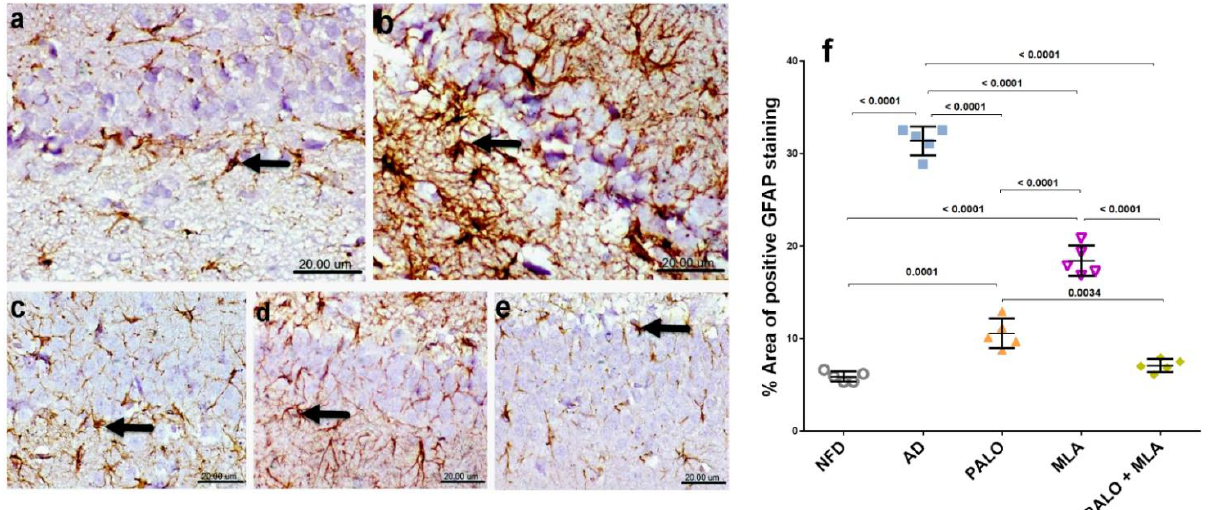
Figure 10. Effects of PALO and/or MLA on hippocampal CA1 immuno-histopathological examination of astrocytes in HFFD/LPS-induced AD model. Immunohistochemical analysis of GFAP expression in the CA1 region of hippocampus of rats in ( a ) NFD group shows normal small-sized astrocytes with lightly stained GFAP positive short processes (arrow), while sections of ( b ) AD model show strong immunoreactivity of hypertrophied astrocytes with deeply stained GFAP positive brown processes (arrow). On the other hand, section of ( c ) PALO treated group shows mild GFAP positive expression (arrow) and section of ( d ) MLA treated group shows moderate GFAP expression (arrow). Meanwhile, section of ( e ) PLAO + MLA treated group depicts normal small-sized astrocytes with lightly stained GFAP (arrow) processes (Scale bar 20 µ m, × 600). Panel ( f ) represents the % area of positive GFAP staining from 5 randomly chosen fields in each section. Data were analyzed using one-way ANOVA followed by Tukey’s post hoc test; p < 0.05 PALO (0.1 mg · kg − 1 ; i.p) and/or MLA (5.6 mg · kg − 1 ; i.p) were administered 3 h after LPS injection and for 8 days. GFAP: glial fibrillary acidic